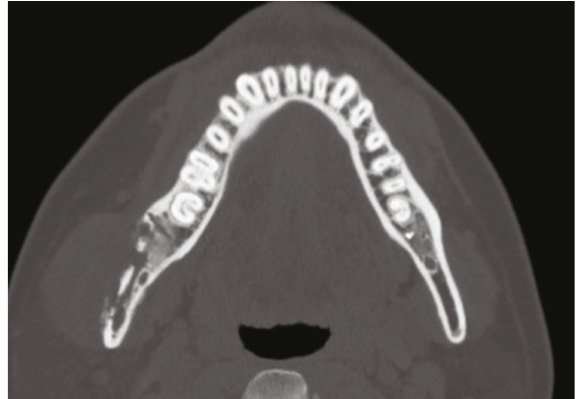
Figure 3: Coronal computed tomography (CT) scans obtained during the initial visit. CT shows a destruction of buccal cortical bone from the socket to the right mandibular angle and a formation of bone sequestrum. Although the lingual cortical bone is intact, there is periosteal reaction around the buccal bone destruction.